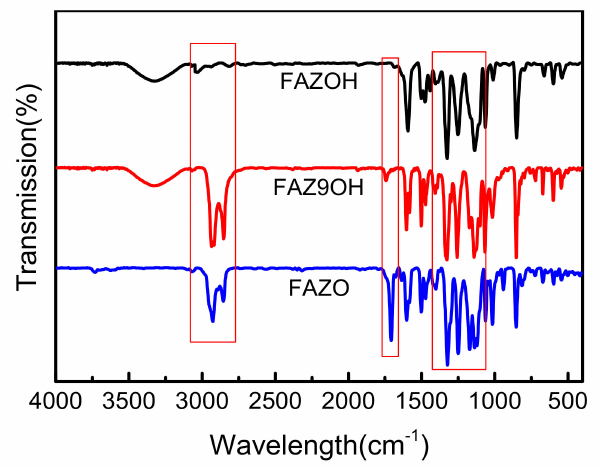
Figure 2. FT-IR spectra of 4-trifluoromethyl-4 (cid:48) -azophenol (FAZOH), 4-trifluoromethyl4 (cid:48) -azophenol etherified with 9-bromo-1-nonanol (FAZ9OH), and